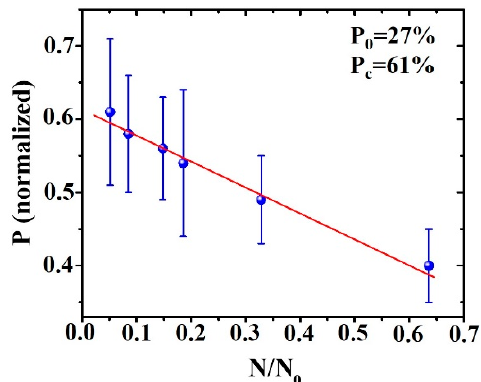
Figure 8. Plot of fraction of surface area covered by Au/Pd film P versus number N of Au/Pd islands normalized to N 0 (starting island density).